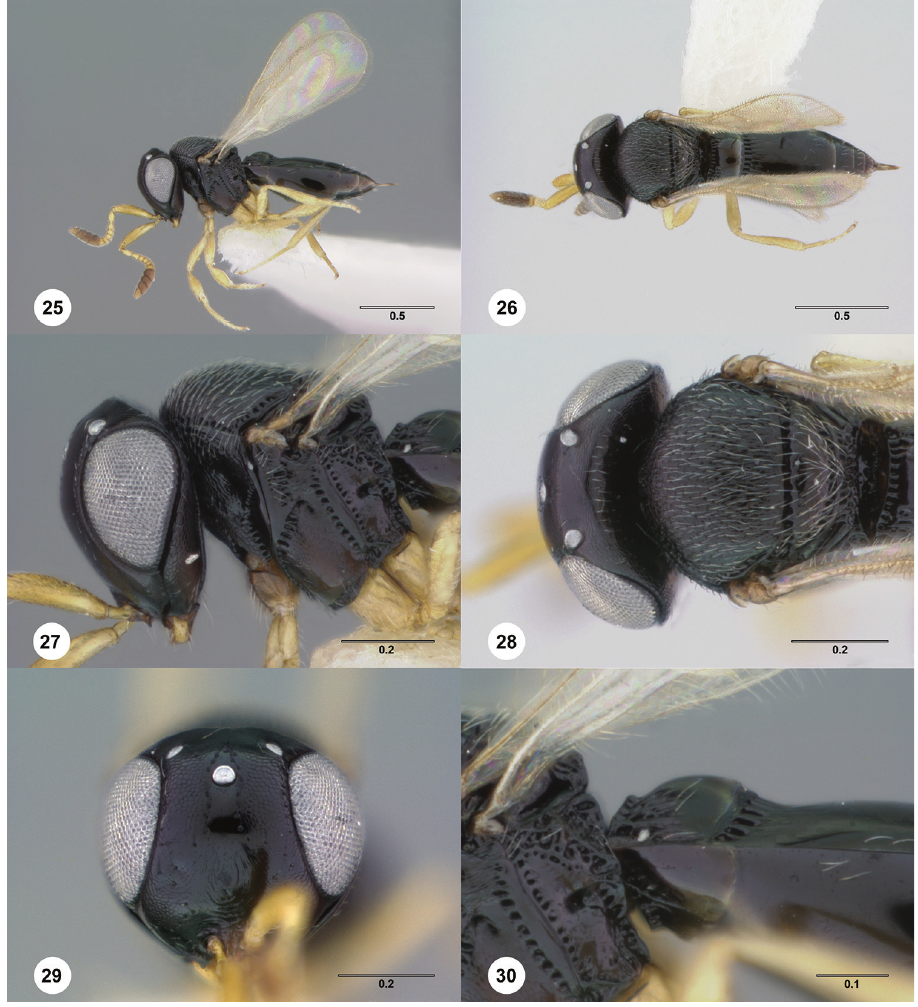
mesosoma, lateral view 28 Head, mesosoma, dorsal view 29 Head, anteroventral view 30 T1–T2, lateral view. Scale bar in